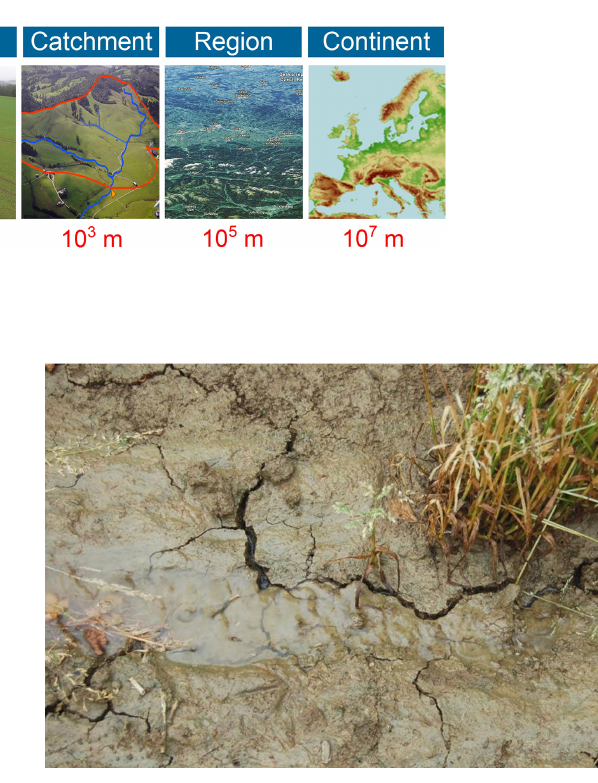
Figure 2. Shrinkage cracks in the Hydrological Open Air Labora- tory (HOAL), Lower Austria, which will lead to preferential infil- tration. Photo: Alexander